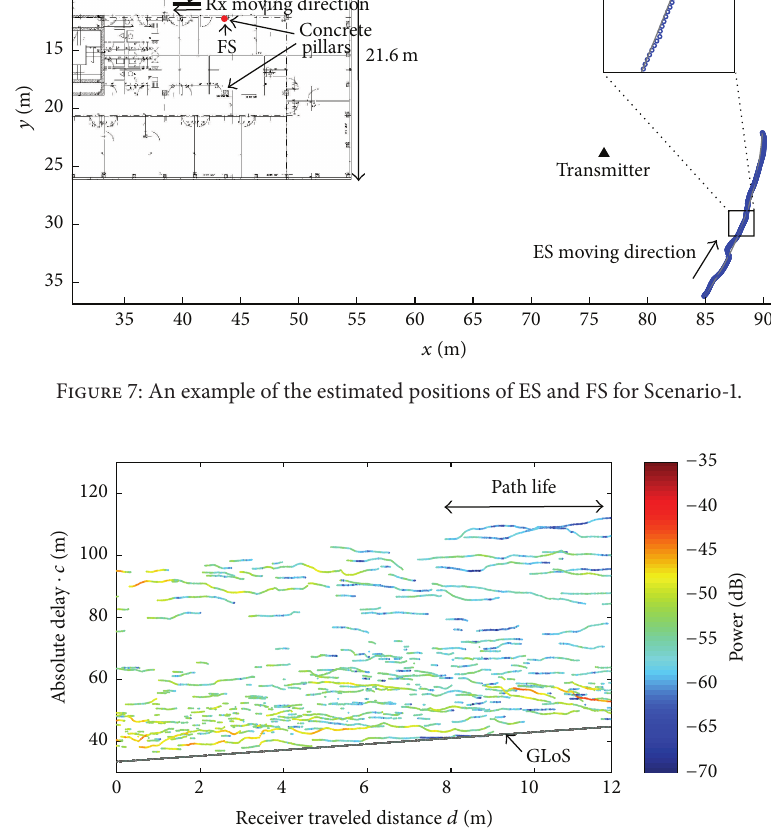
Figure 8: Example of estimated time variant CIRs for Scenario-1 while the receiver was moving along track 𝑅 1 and the transmitter was located at 𝑇 3 . 𝑐 is the speed of light. The grey curve represents the GLoS path delay. The power is normalized to the free space